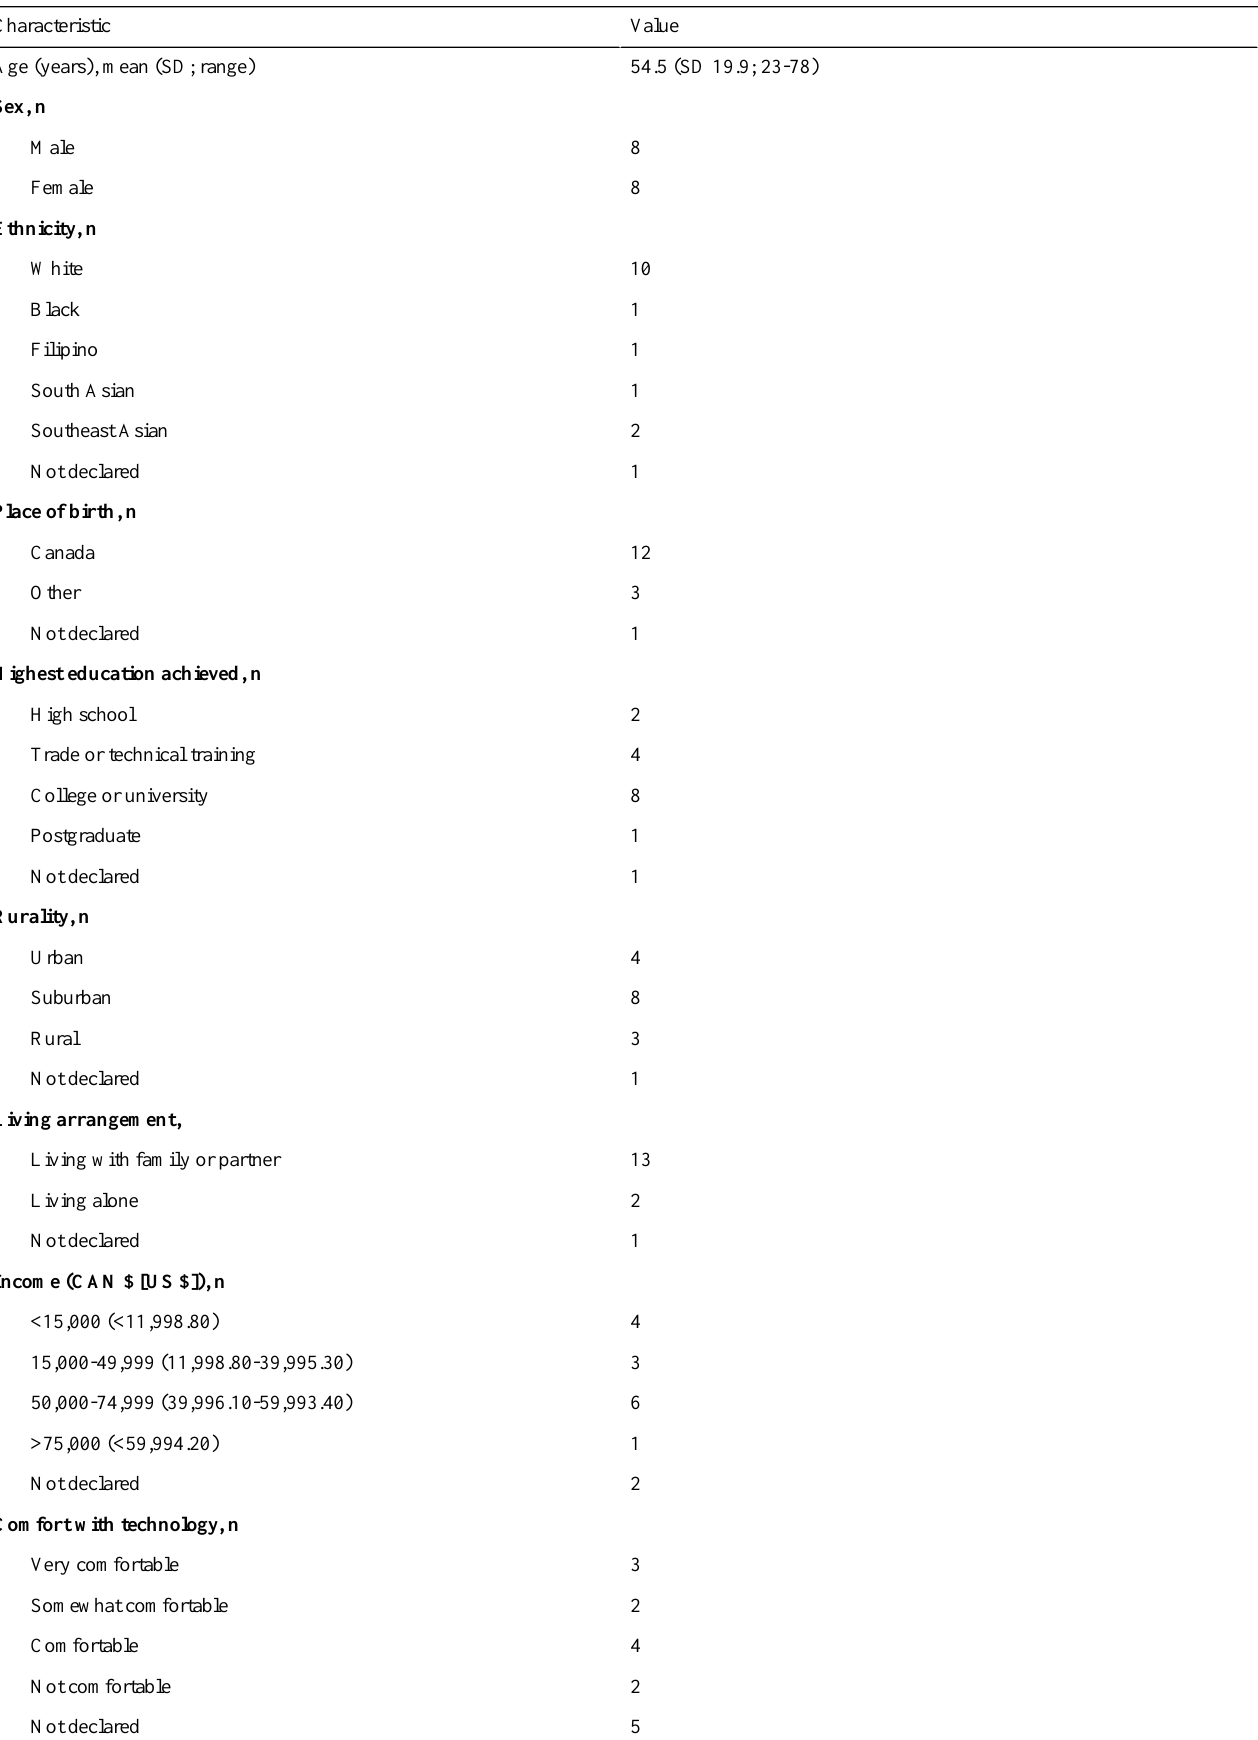
Table 1. Characteristics of patient interview participants (N=16).